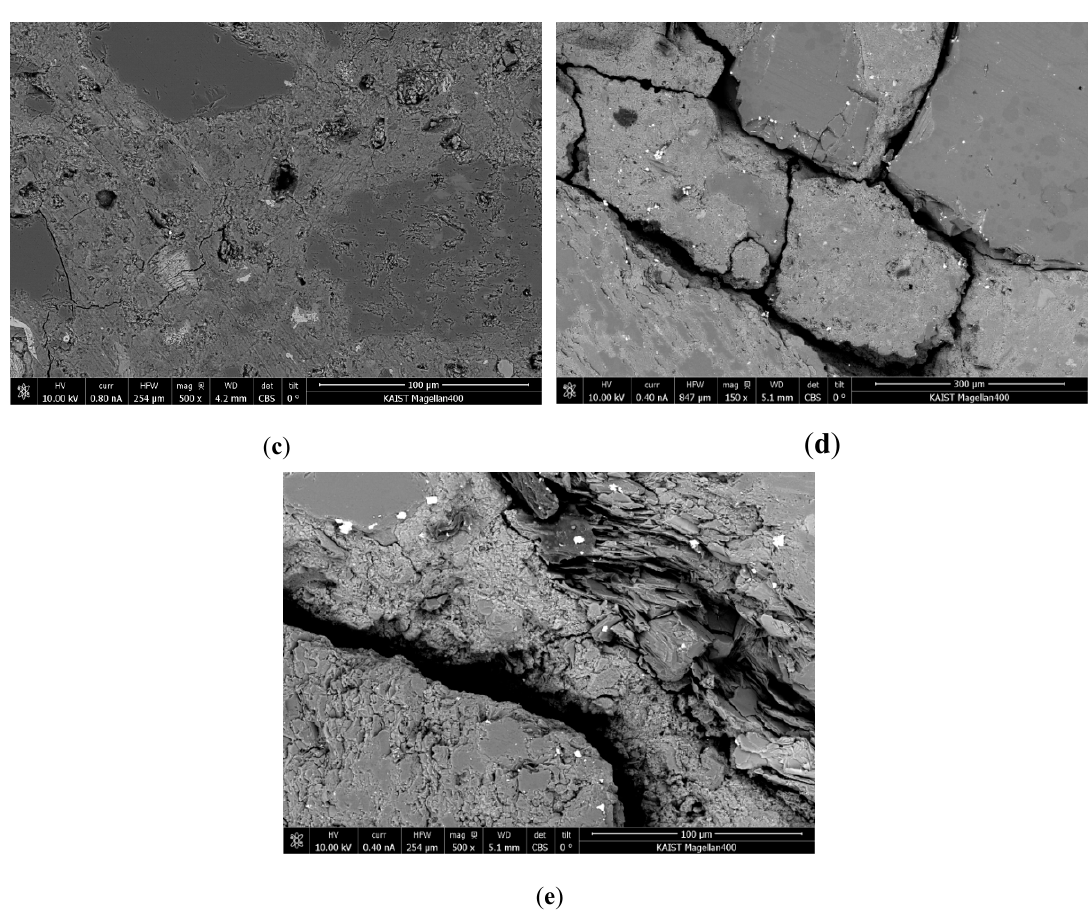
Figure 3. ( a ) Freezing and thawing damage to the concrete surface of sample A ; SEM micrographs of undamaged concrete before cycles of freezing and thawing with a 150× magnification ( b ) and a 500× magnification ( c ), and damaged concrete after 70 cycles of freezing and thawing with a 150× magnification ( d ) and 500× magnification ( e ).